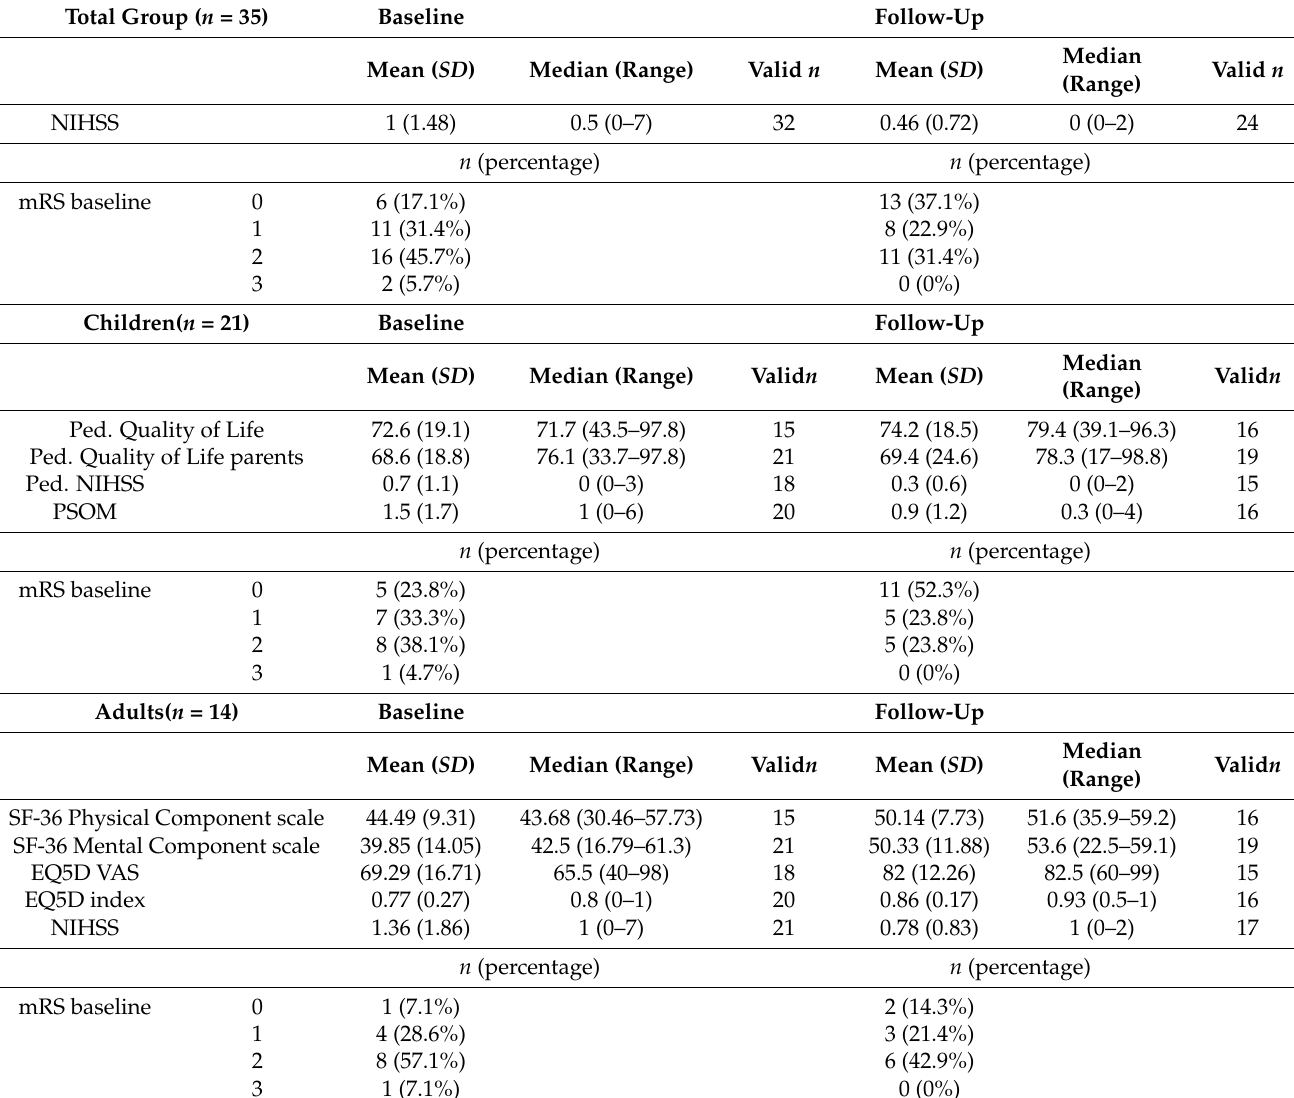
Table A2. Clinical outcome